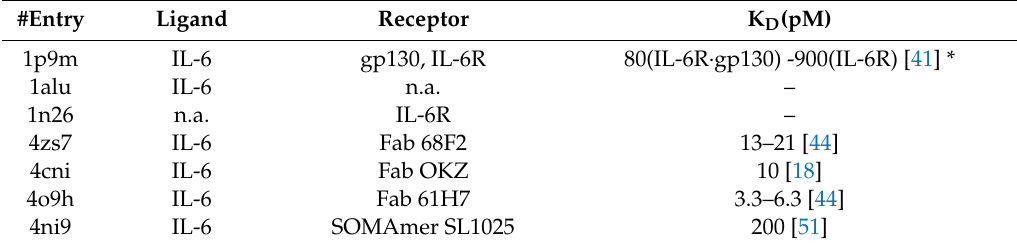
* data refer to the trimeric